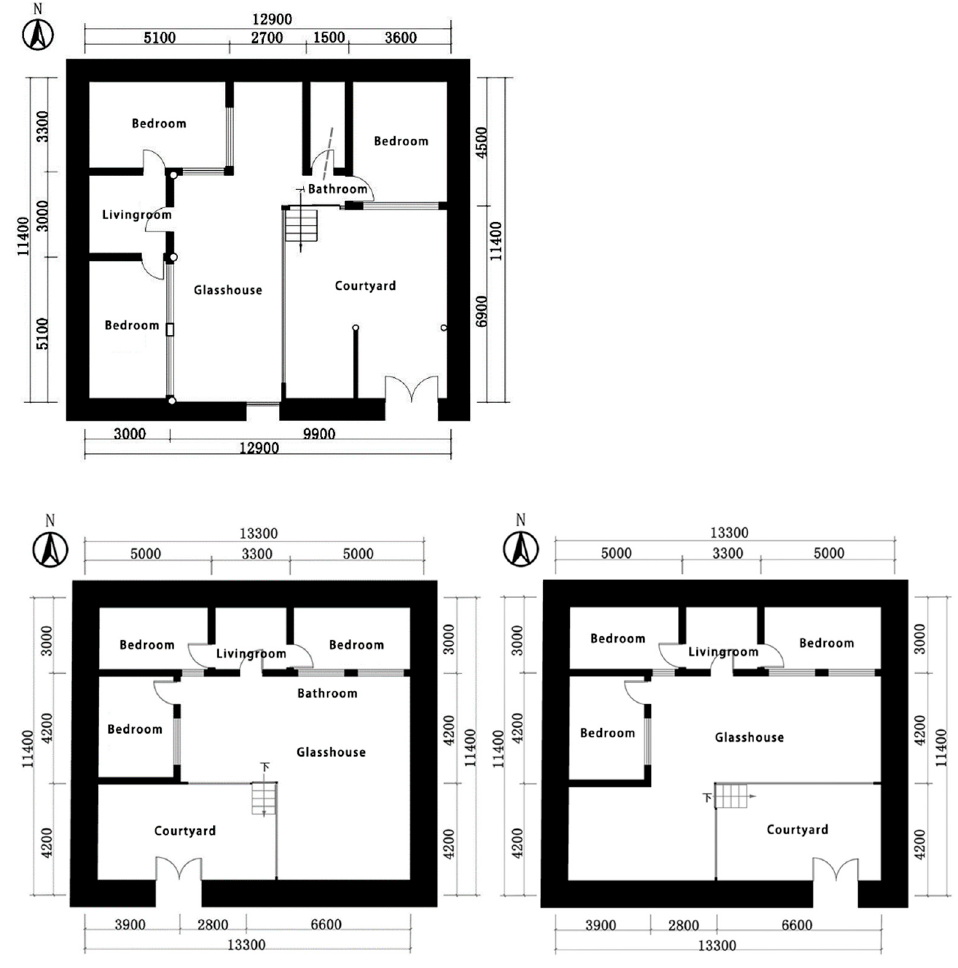
Figure 6. Plan of the monastery selected for measurement (source: self-drawn).